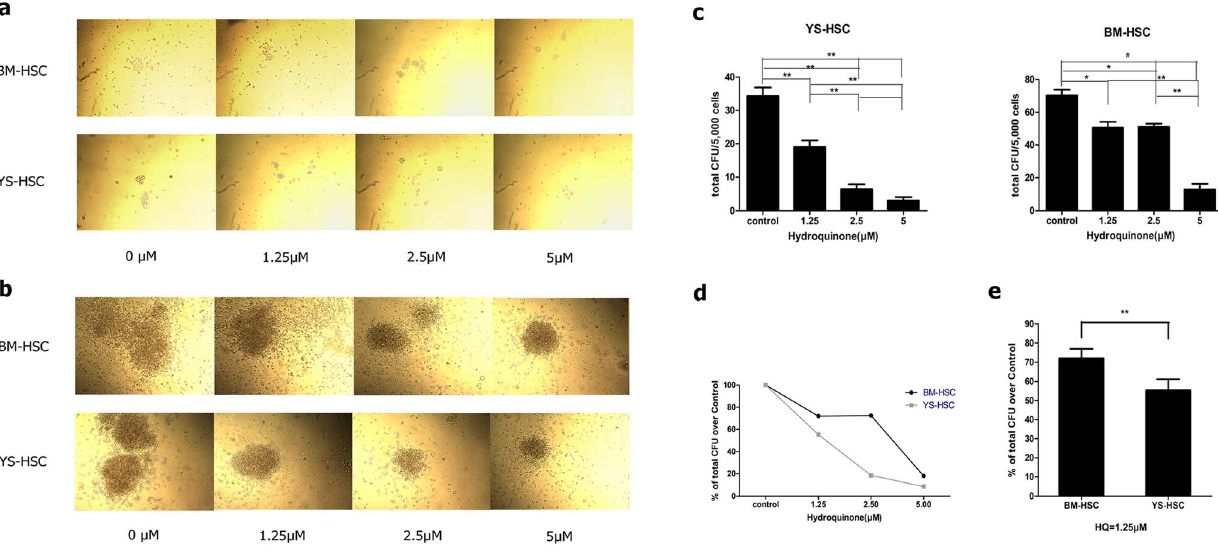
Figure 3. Effect of HQ on CFU of YS-HSC and BM-HSC after 7 days of culture in vitro. Five thousand cells were sorted directly into the methylcellulose medium containing 0, 1.25, 2.5, or 5.0 m M hydroquinone supplemented with SCF, IL-3, IL-6, and Epo. Colony numbers were counted on day 7. Each experiment was done in triplicates. Quantitative data represents the average number of colonies per dish. ( a ) Morphology of CFU-E/ BFU-E of BM-HSC and YS-HSC after 7d culture. ( b ) Morphology of CFU-GM of BM-HSC and YS-HSC after 7d culture. ( c ) CFU numbers of BM-HSC and YS-HSC. ( d ) Comparison of total CFU as percent of control between BM-HSC and YS-HSC. ( e ) Comparison of total CFU as percent of control between BM-HSC and YS-HSC treated with HQ at 1.25 m M. Data represent means 6 SDs of three or more separate experiments (*, P , 0.05; **, P , 0.01; and # , P , 0.001). CFU-GM includes CFU-granulocyte (CFU-G), CFU-macrophage (CFU-M), and CFU-granulocyte macrophage (CFU-GM). CFU-E represents colony-forming unit-erythroid. BFU-E represents burst-forming